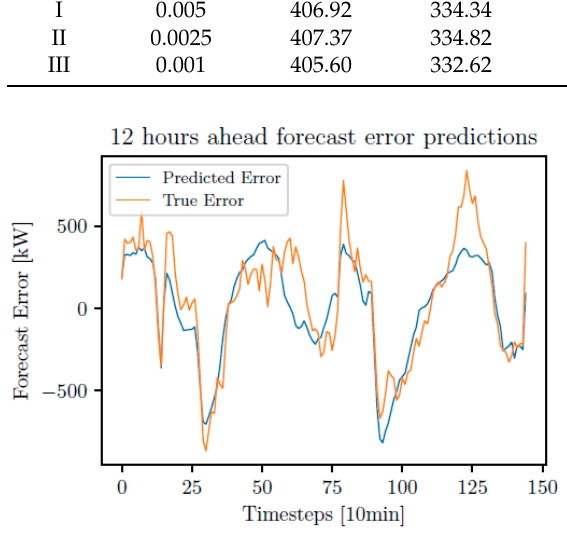
Figure 19. Twelve-hours-ahead error forecasts.